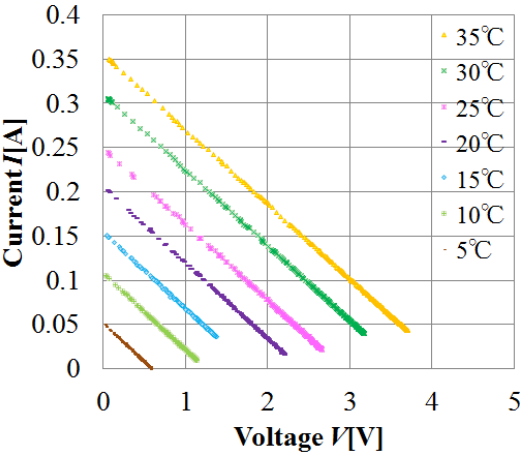
Figure 1. V-I Characteristic of the thermoelectric module.